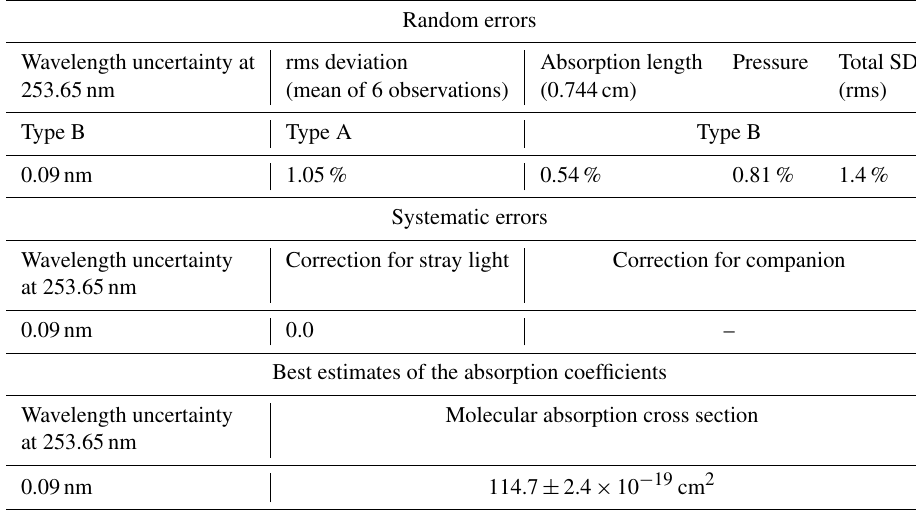
Table 1. Summary of uncertainties as reported by Hearn (1961).